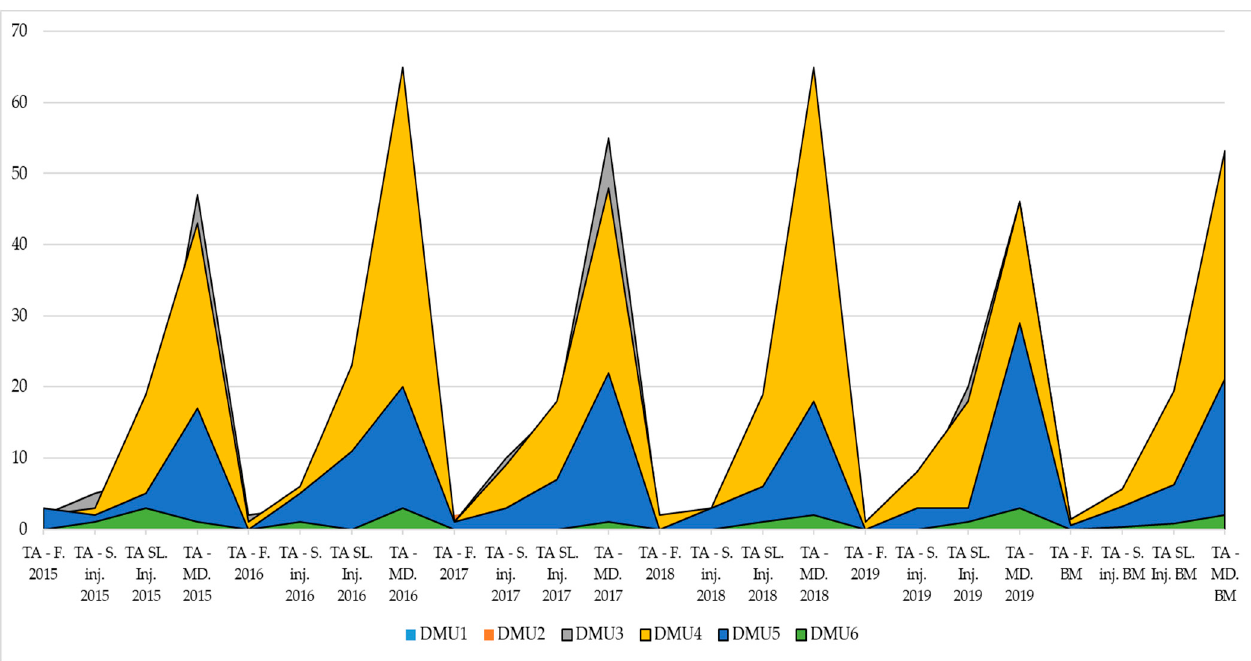
Figure 4. The total number of traffic accidents on all road sections in the period 2015–2019. In order to obtain the final data that will represent the input, i.e., output of the DEA model, it is necessary to use the Dombi aggregator for averaging the historical data for the AADT as inputs, and the Bonferroni aggregator for averaging all outputs of the DEA model. An example of the application of both aggregators and the averaging of the stated values is shown below. The AADT values for the first and second DMU are obtained using a Dombi aggregator as follows: